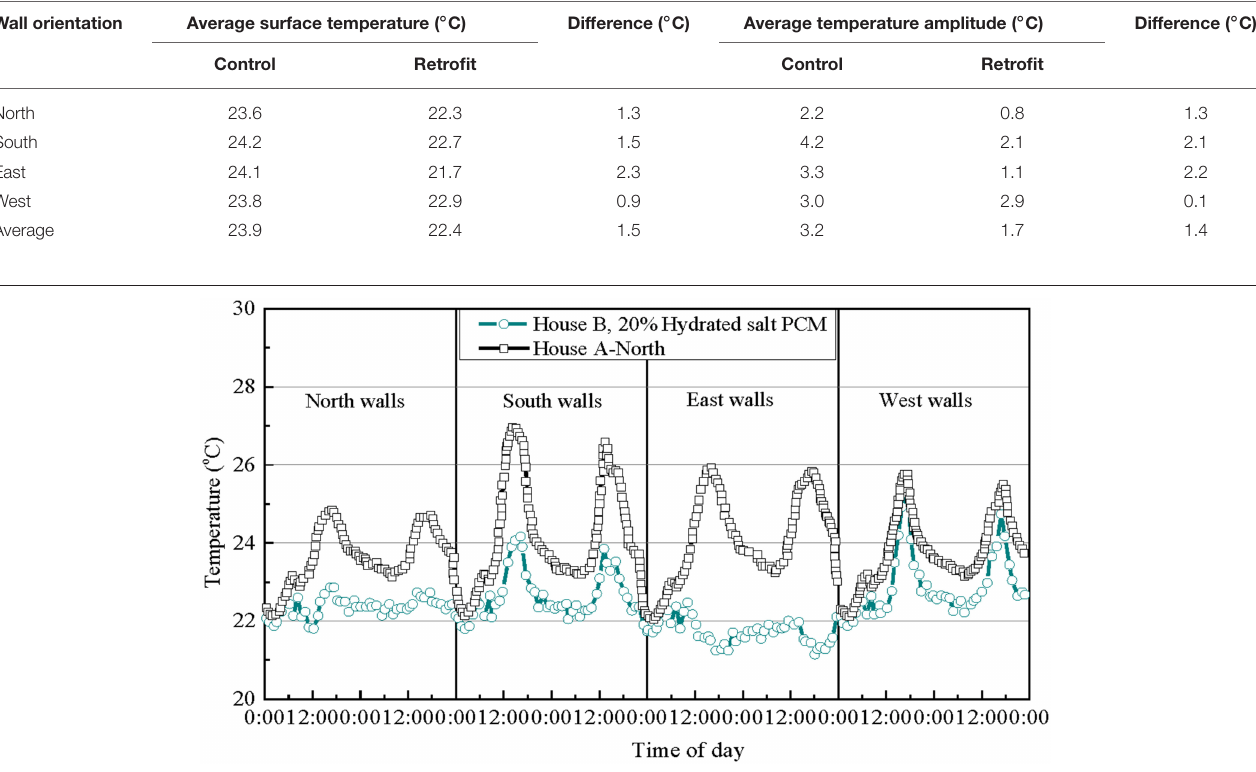
TABLE 5 | Reductions in inside wall surface temperatures and reductions in temperature fluctuations produced by using 20 wt% PCMs. Wall orientation